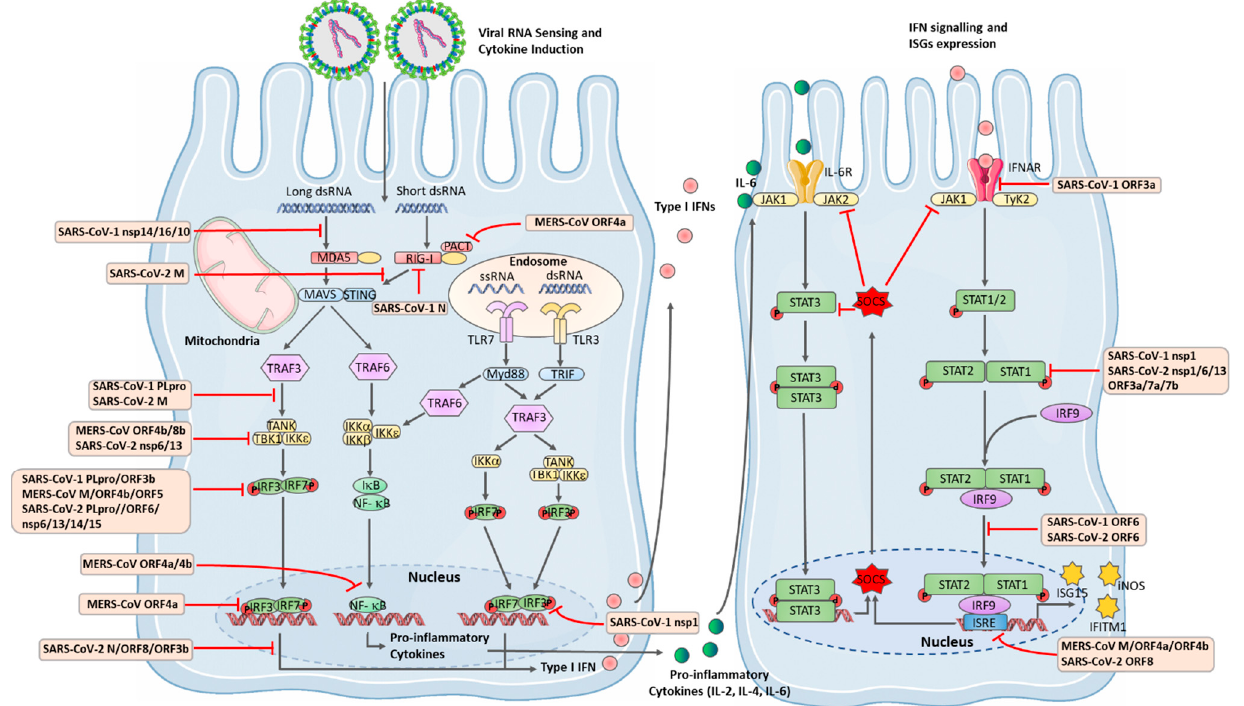
Figure 4. The RLR, TLR and JAK-STAT signalling pathways and interference of signalling pathways by structural and non-structural proteins of coronaviruses. Endosomal TLR3 and TLR7 recognise dsRNA and ssRNA, respectively, leading to activation of NF- κ B, which can promote the expression of pro-inflammatory cytokines. TLR3 also triggers IRF-3 activation leading to IFN production. In the JAK-STAT pathway, binding of the receptor leads to its autophosphorylation. Then, Tyk2 and JAK1, which are bound to the intracellular domain of IFNAR, are activated and cause subsequent phosphorylation of STAT1 and STAT2. Phosphorylated STAT1 and STAT2 dimerise and associate with a transcriptional regulator IFR9 (IFN regulatory factor 9), forming the heterotrimeric transcriptional factor complex IFN-stimulated gene factor 3 (ISGF3). Then, ISGF3 translocates to the nucleus and binds to the ISRE promoter of target ISGs. Several coronavirus proteins, which evade anti-viral immune response, are also shown.